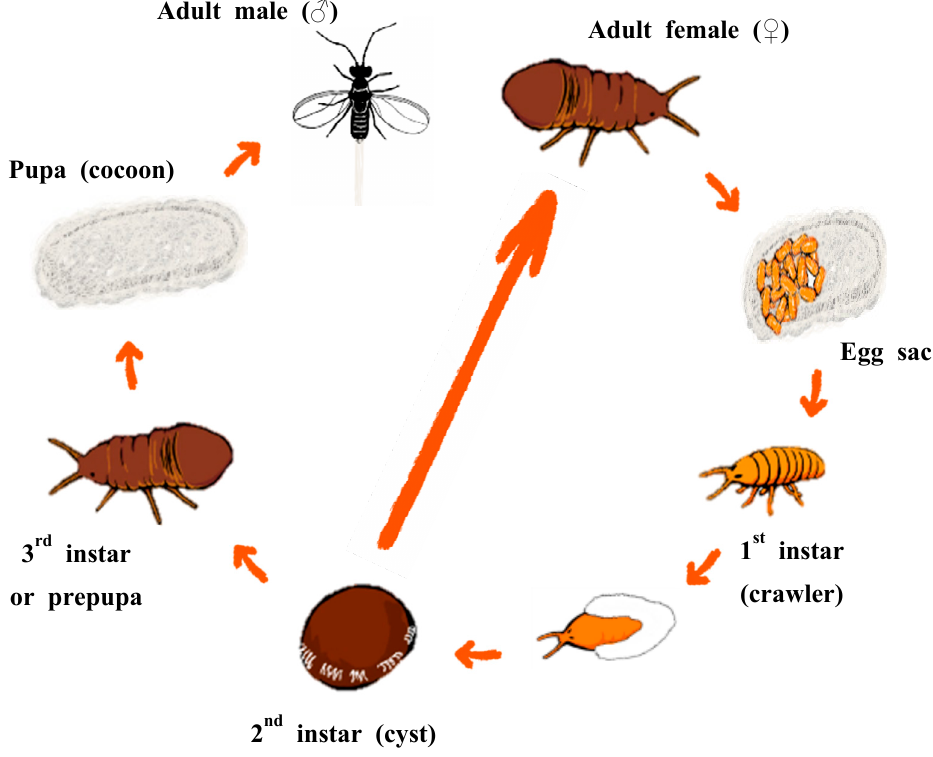
Figure 1. General life cycle of Matsucoccus species.